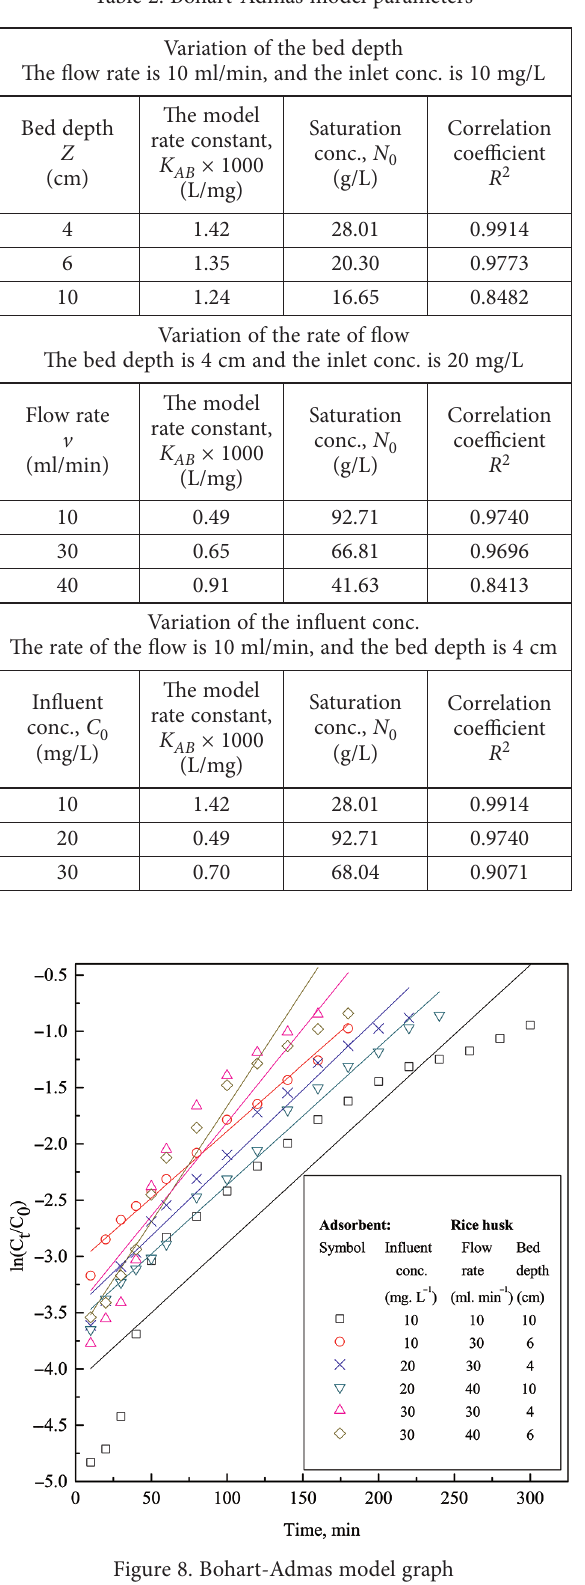
Figure 8. Bohart-Admas model graph